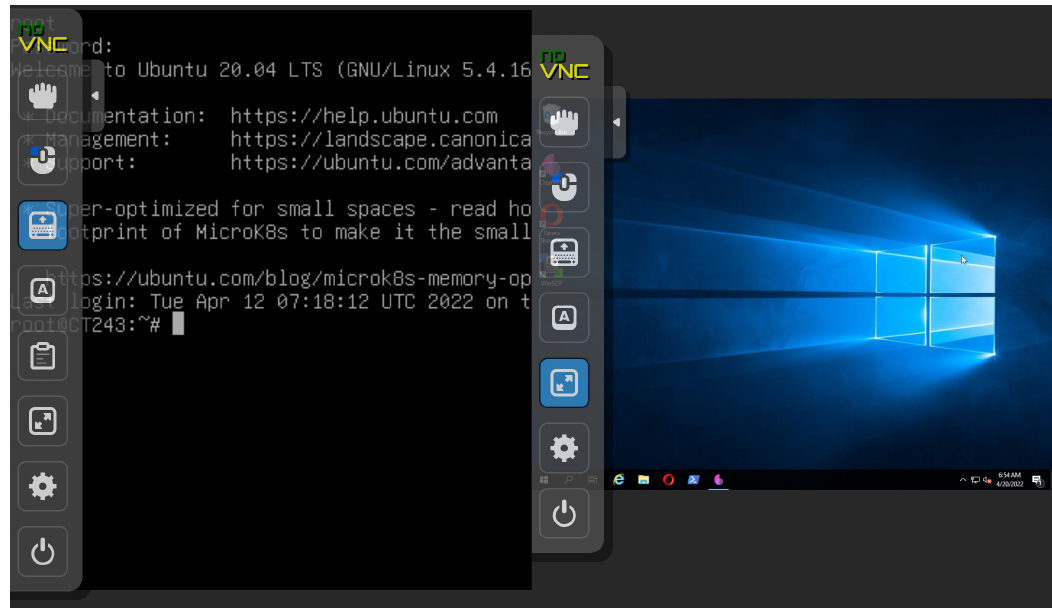
Figure 5: Mobile versions of CLI and GUI in Proxmox VE.